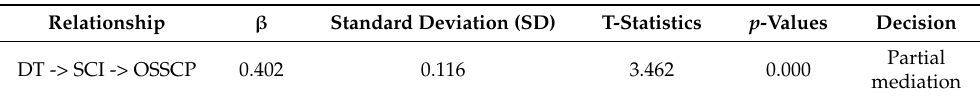
Table 7. Mediating